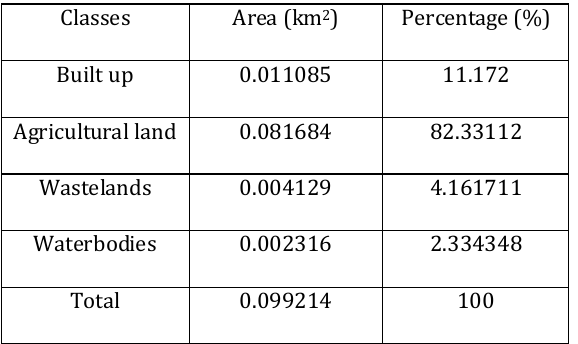
Table 1. Table showing different LULC classes and their